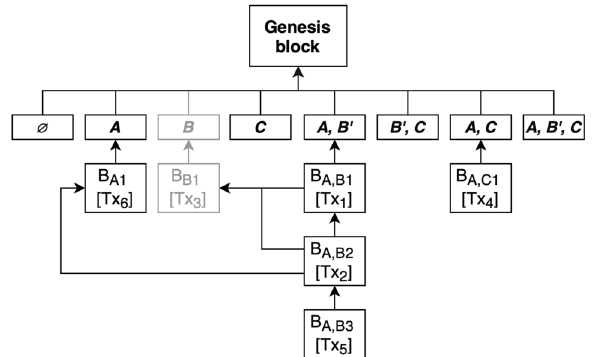
Figure 3. Instead of putting individual’s sensitive data in shared chains, it can be put in one party’s subchain and then pointed to from the other, shared transaction. Deleting only the subchain of the leaving party is